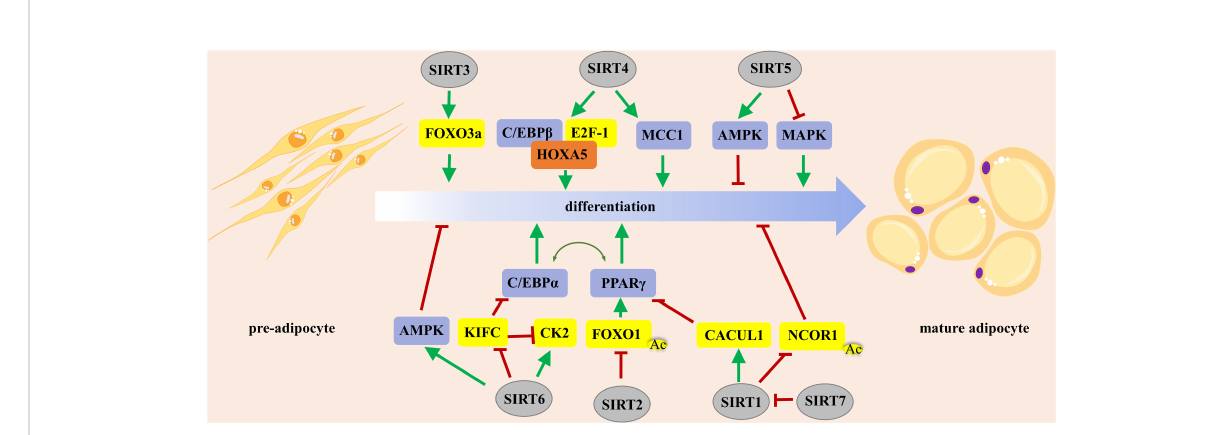
FIGURE 1 The roles of Sirtuins in regulating adipocyte differentiation. PPAR g and C/EBP a are the master regulators of preadipocyte commitment and terminal differentiation. FOXO plays an important role in the integration of hormone-activated signaling pathways with the complex transcriptional cascade that promotes adipocyte differentiation. PPAR g , peroxisome proliferator-activated receptor g ; FOXO, forkhead box